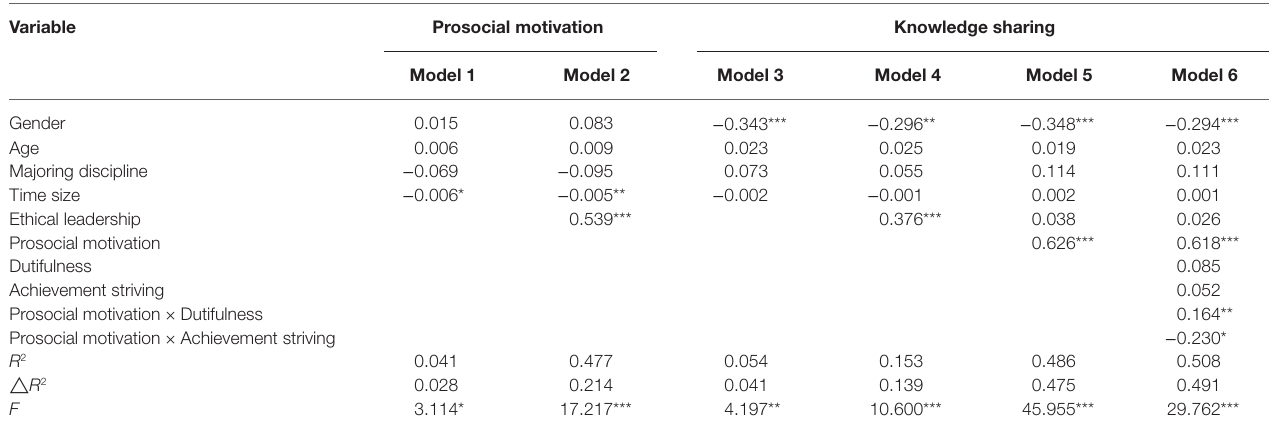
TABLE 3 | Results of regression